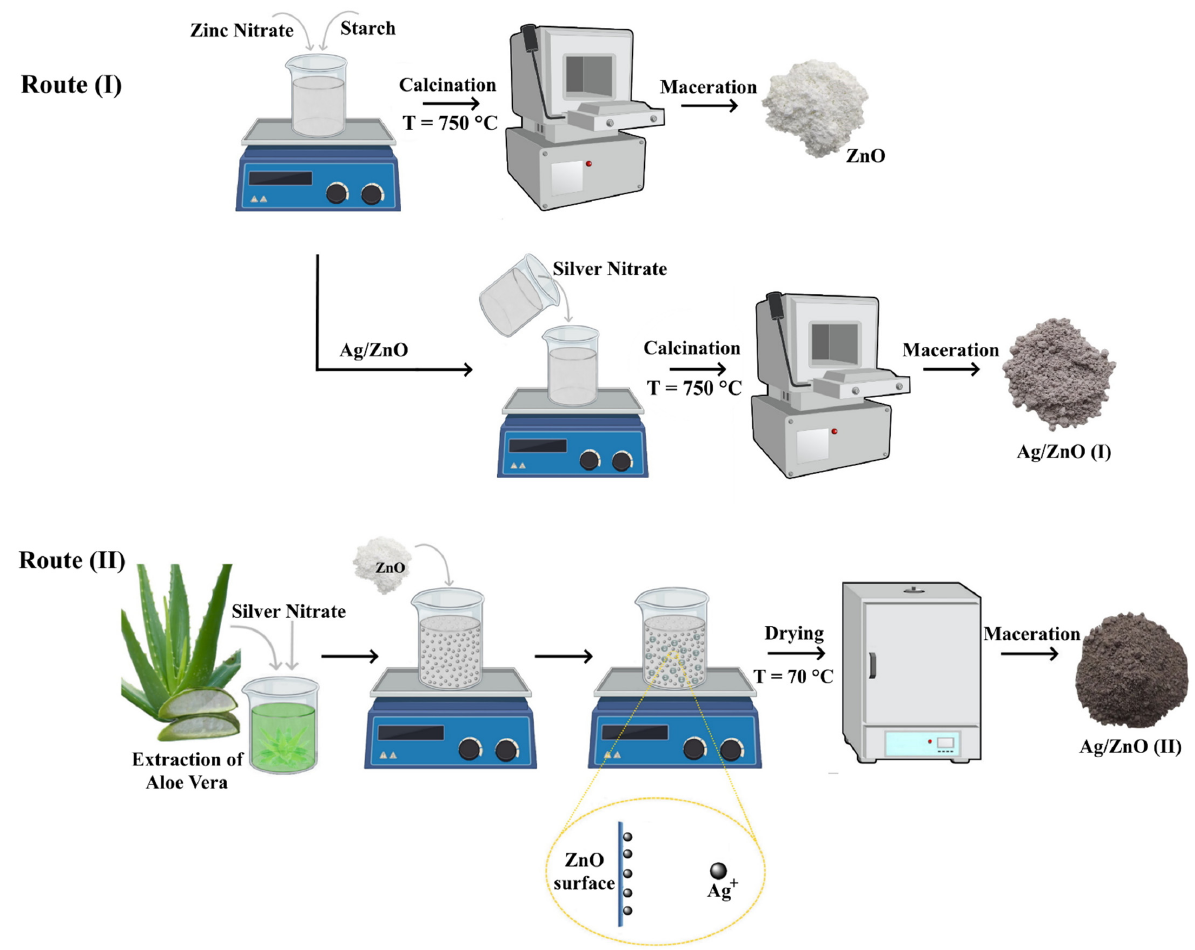
Figure 1. Schematic diagram of the synthesis routes used.